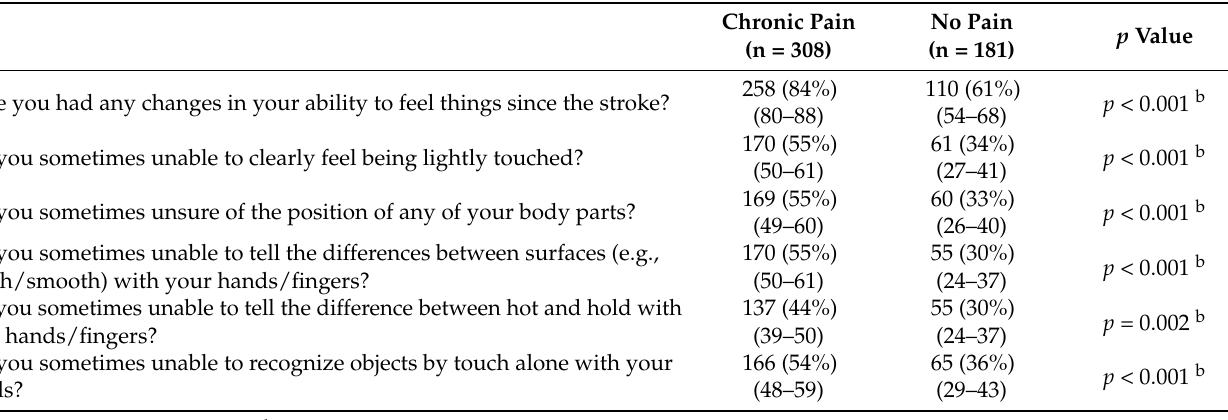
Table 4. Relationship between reported presence and/or features of somatosensory impairment and chronic pain after stroke, with confidence intervals (95%)